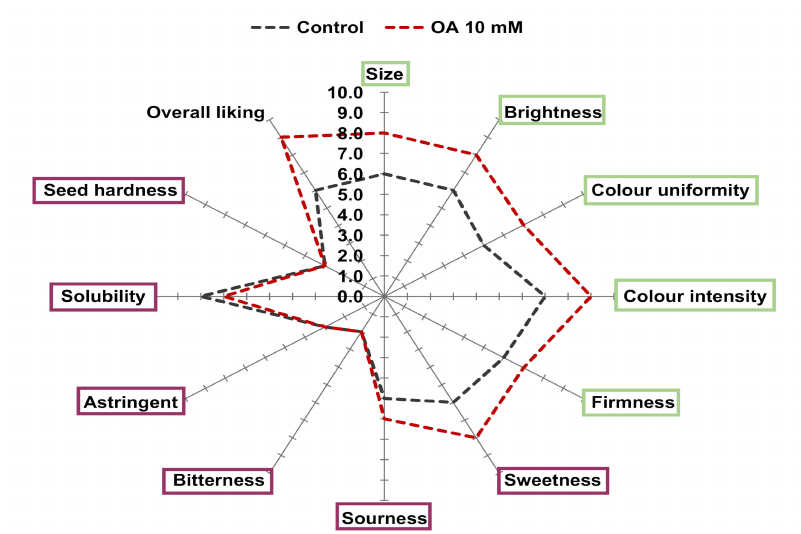
Figure 3. Descriptive sensory analysis of oxalic acid (OA) 10-mM-treated and non-treated (control) pomegranate fruit in the 2017 experiment. Size, brightness, color uniformity and intensity, firmness, sweetness, sourness, bitterness, astringence, solubility, seed hardness, and overall liking were evaluated by trained panelists in a hedonic scale from 0 to 10 points. Parameters highlighted by a green and purple box were evaluated in the whole fruit and in the arils,